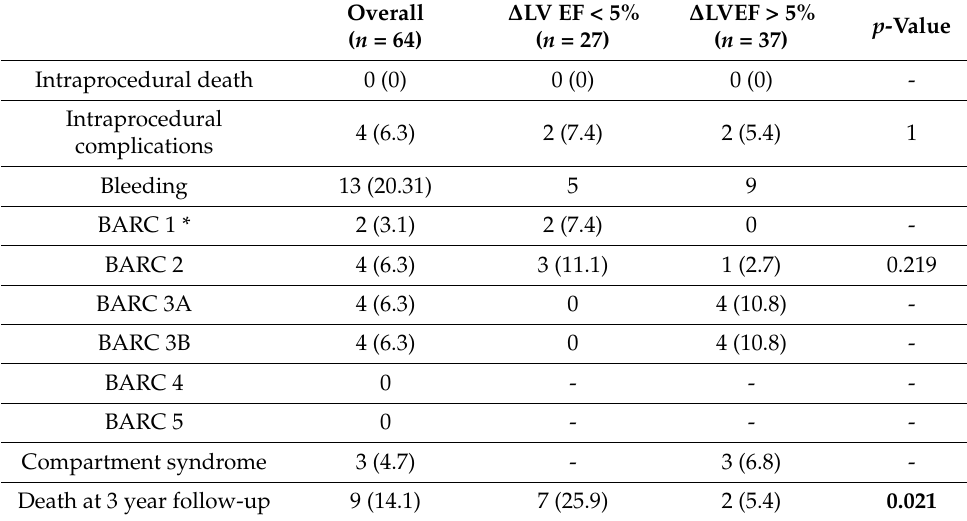
Table 3. Complications and outcomes in the study